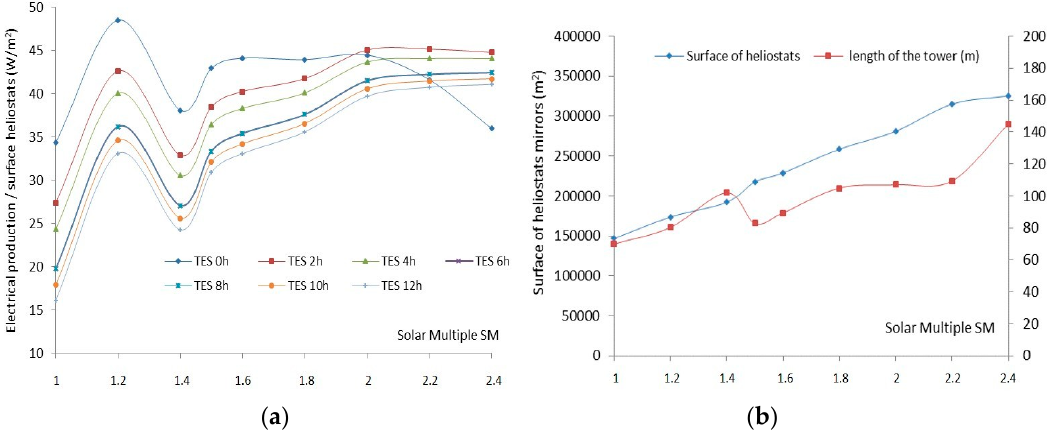
Figure 5. ( a ) Solar multiple effect ( SM ) on electrical production per surface heliostats under different values of TES . ( b ) Solar multiple effect on the surface of heliostats mirrors (m 2 ) and length of the tower (m).